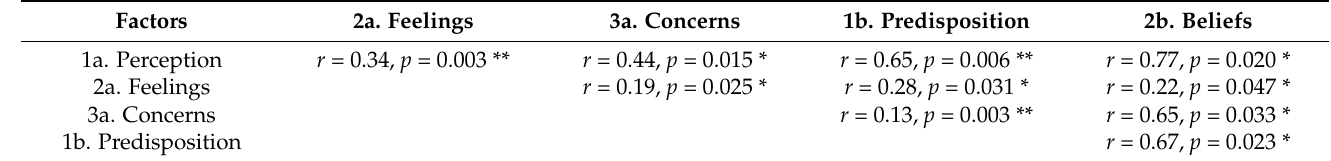
Table 2. Correlationals among attitudinal factors (1a, 2a, 3a, 1b, 2b).